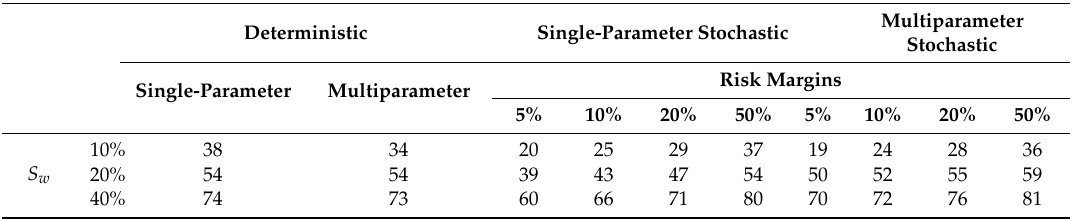
Table 7. Case study’s remaining time (in years) before action for the defined degradation levels, by